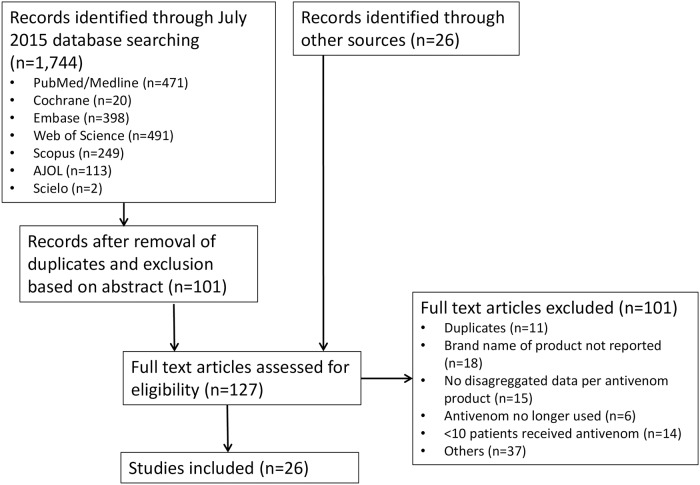
Search strategy.